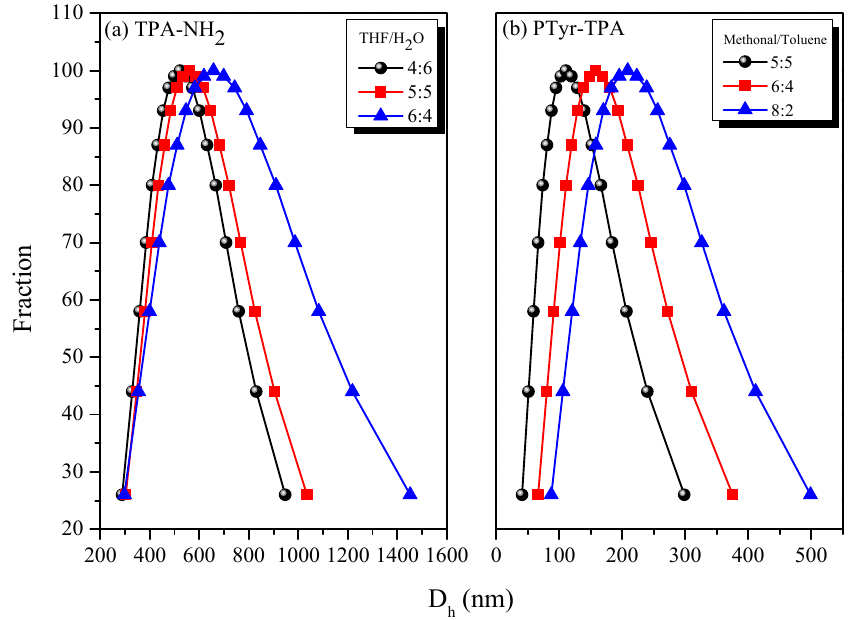
Figure 8. DLS analyses of: ( a ) TPA-NH 2 in THF/H 2 O; and ( b ) PTyr-TPA in CH 3 OH/toluene, with various amounts of the poor solvents.